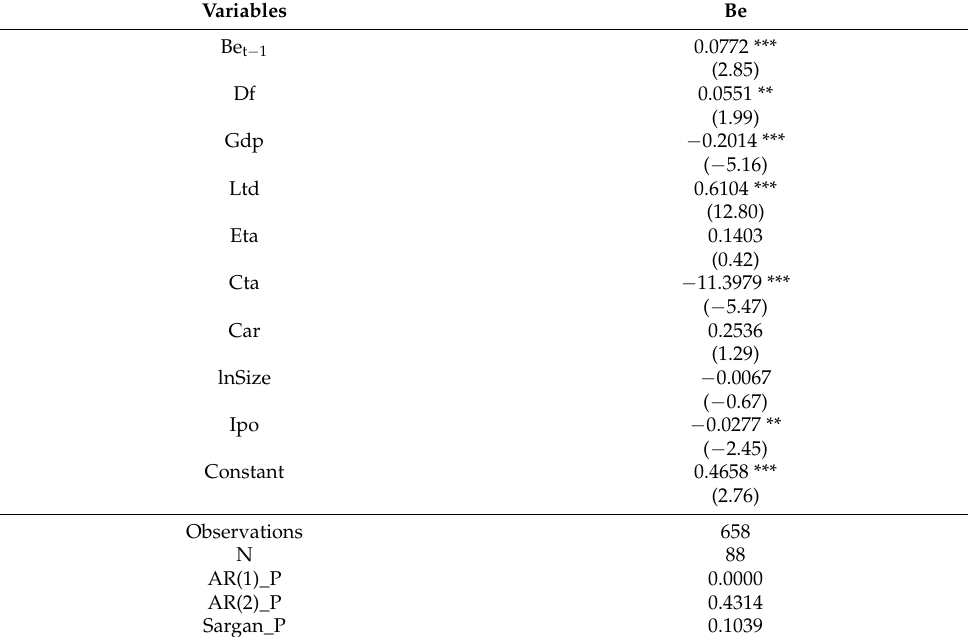
Table 9. Endogeneity